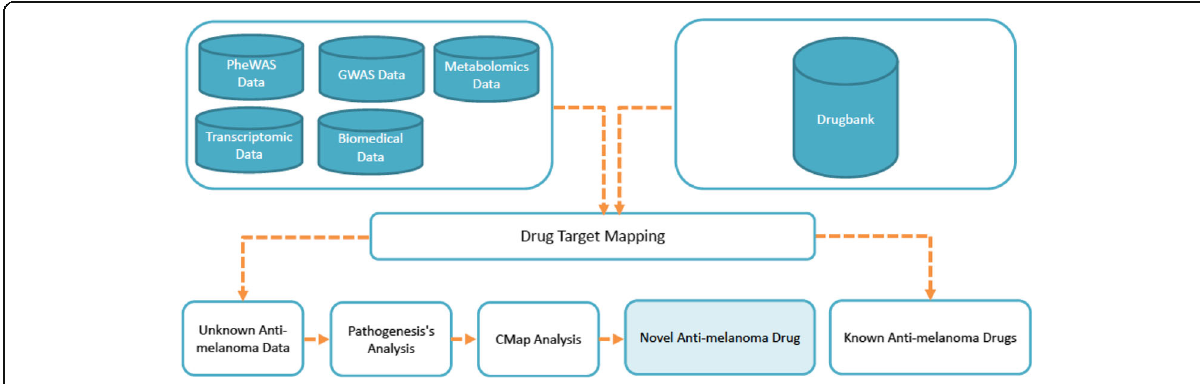
Fig. 1 Drug repurposing approach to identify novel anti-melanoma drugs; in this approach we have collected melanoma responsive genes/proteins and identified target genes by drug target mapping with the help of drugbank. We have removed all known anti-melanoma drugs and analyzed the unknown anti-melanoma drugs by pathogenesis information and CMap analysis. We have found 35 drugs interacting with 20